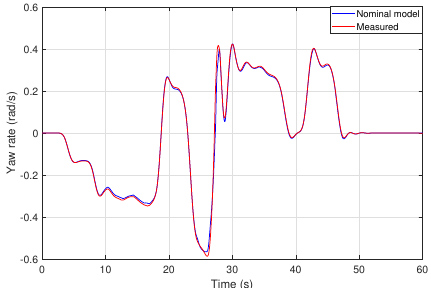
Figure 14. Reference and measured yaw-rate.